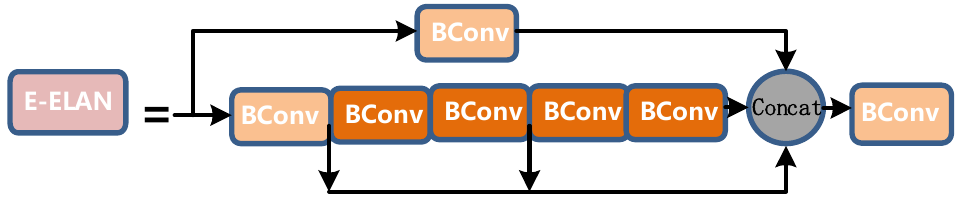
Figure 8. E-ELAN layer diagram.